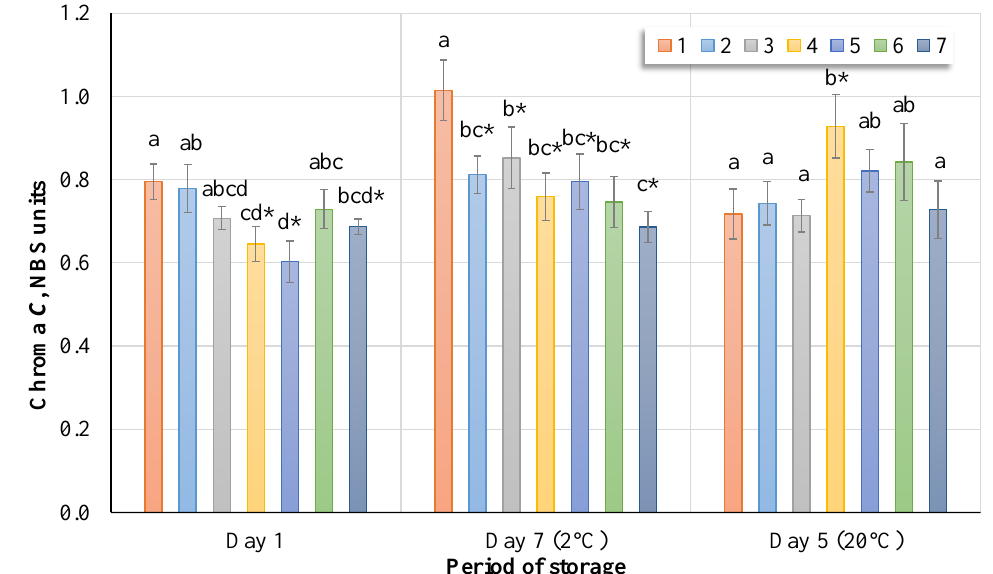
Figure 6. Changes in the chroma C of birch sap during storage: 1 (control)—untreated sap (initial); 2—sap ozonated for 5 min; 3—sap ozonated for 10 min; 4—sap ozonated for 15 min; 5—sap ozonated for 20 min; 6—sap ozonated for 25 min; 7—sap ozonated for 30 min. Dunnett tests treat one group as a control (No. 1) and compare all other groups against it. A significant difference between the control group and the other treatment groups is denoted by an asterisk “*”. Tukey HSD test was used for the comparison of processing methods (marked in lowercase). The mean difference is significant at the 0.05 level ( n = 18).